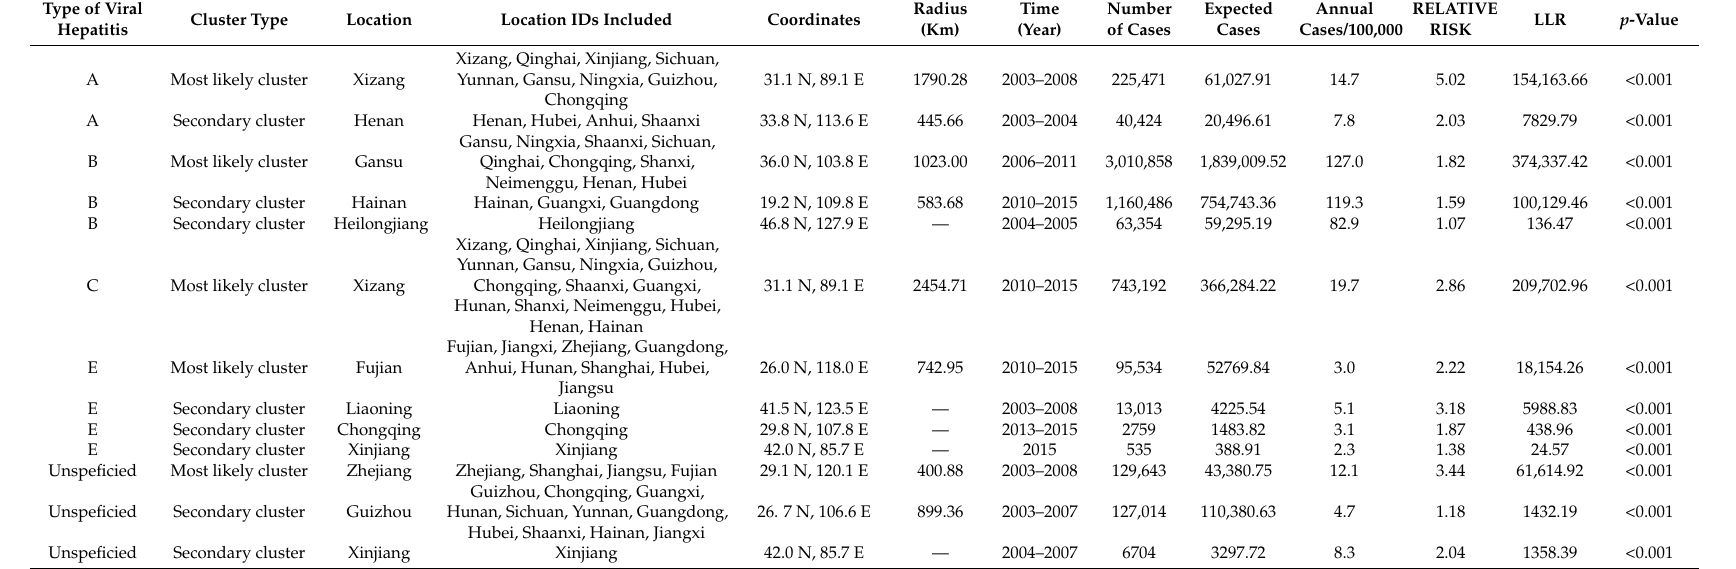
Table 3. The mostly likely clusters and secodary clusters of viral hepatitis in China 3